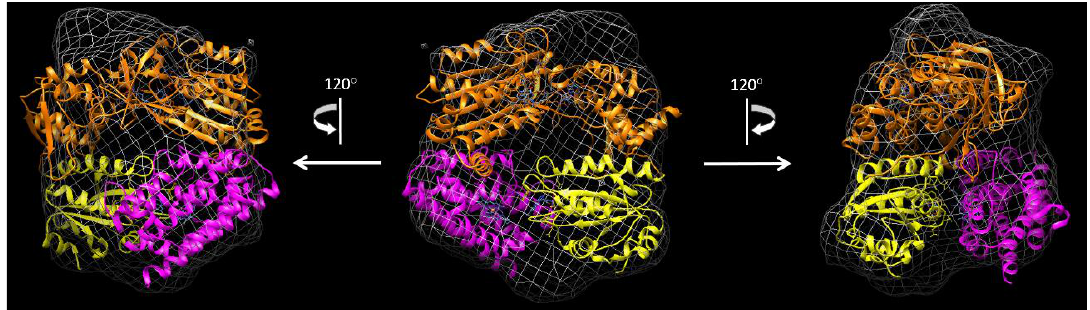
Figure 5. Three-dimensional reconstruction of the rCPR–heme–rHO-1 complex structure from a cryo-electron microscopic image (gray net); comparison with the X-ray structure of the ∆ TGEE–heme–HO-1 complex (PDB ID: 3WKT). Resolution of the structure from cryo-EM was calculated as 25 Å. The X- ray crystal structures of the ΔTGEE– heme – HO-1 complex are indicated by ribbon diagrams: magenta, rHO-1; yellow, FMN domain of ΔTGEE; orange, FAD domain of ΔTGEE.